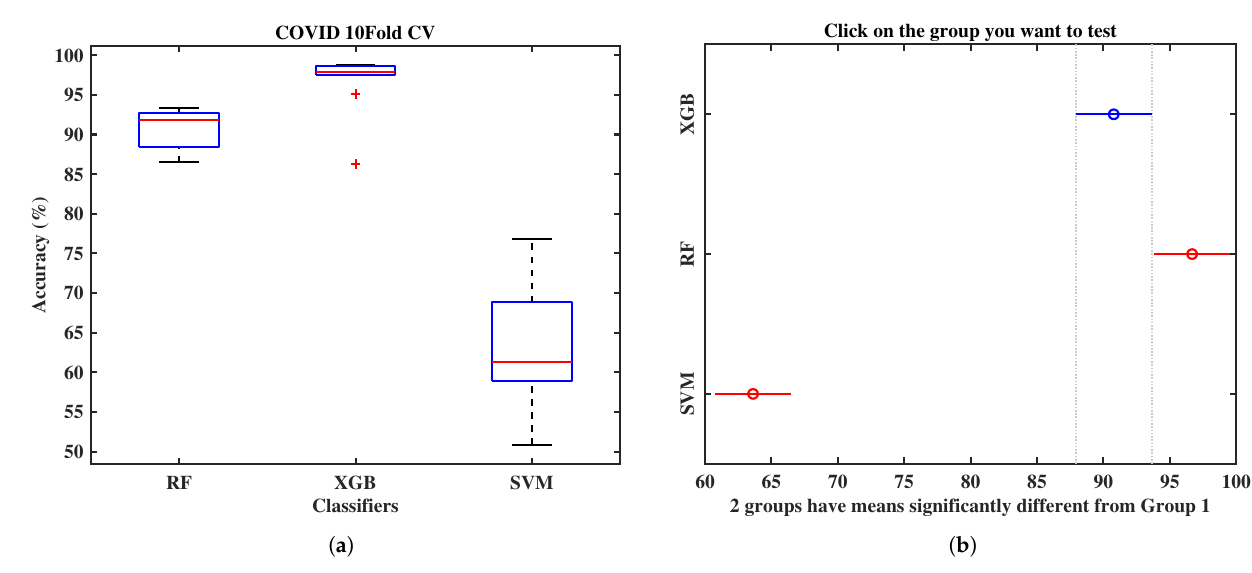
Figure 6. ( a ) Box and Whisker plot of 10-fold CV of the main three ML classifiers and ( b ) a multi- comparison test of the three trained models in this